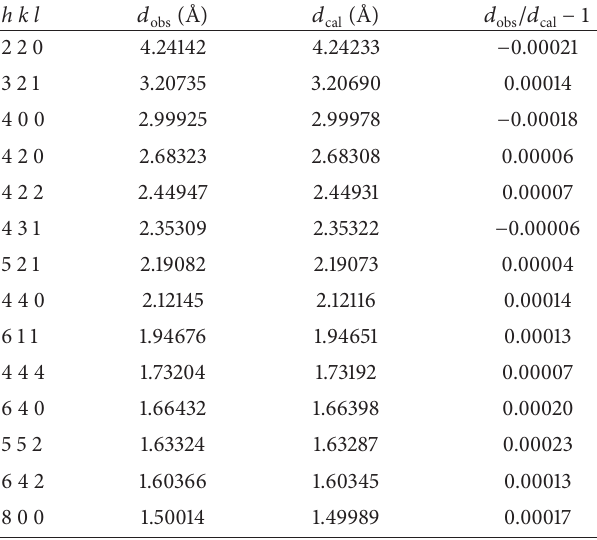
Table 1: Observed and calculated X-ray diffraction patterns of Y (SiO ) at ambient conditions. Mg 3 2 4 3